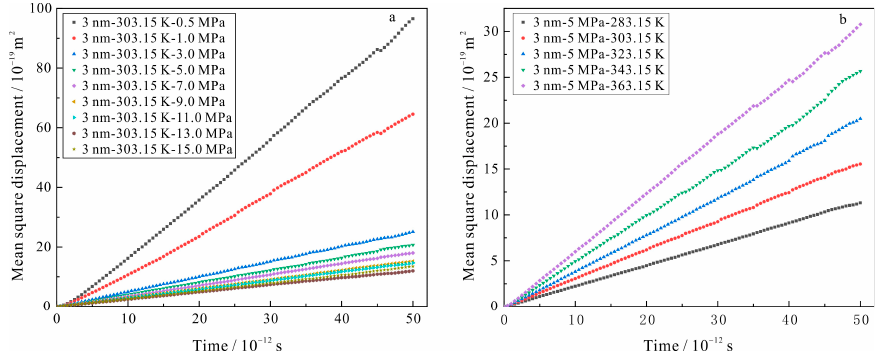
Figure 11. ( a ) Mean square displacement for FK–3 coal, calculated from molecular dynamics simu- lations, as function of time for different pressures; ( b ) and